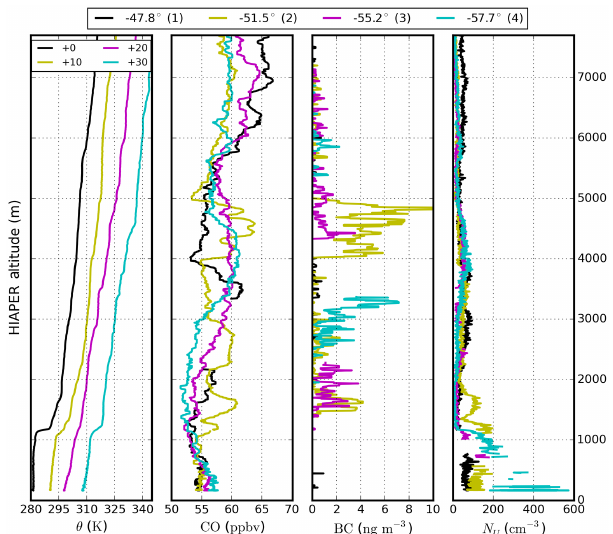
Figure 9. Trace gas and aerosol profiles for comparison flight RF06. From left: potential temperature ( θ , note offset of 10K between profiles); Aerolaser VUV resonance fluorescence carbon monox- ide concentration (CO); SP2 black carbon (BC) mass concentration; and UHSAS number concentration ( N U ; missing for in-cloud con- ditions). Note that the y scale is different to Figs. 4 and 5, and now shows the entire vertical extent of the